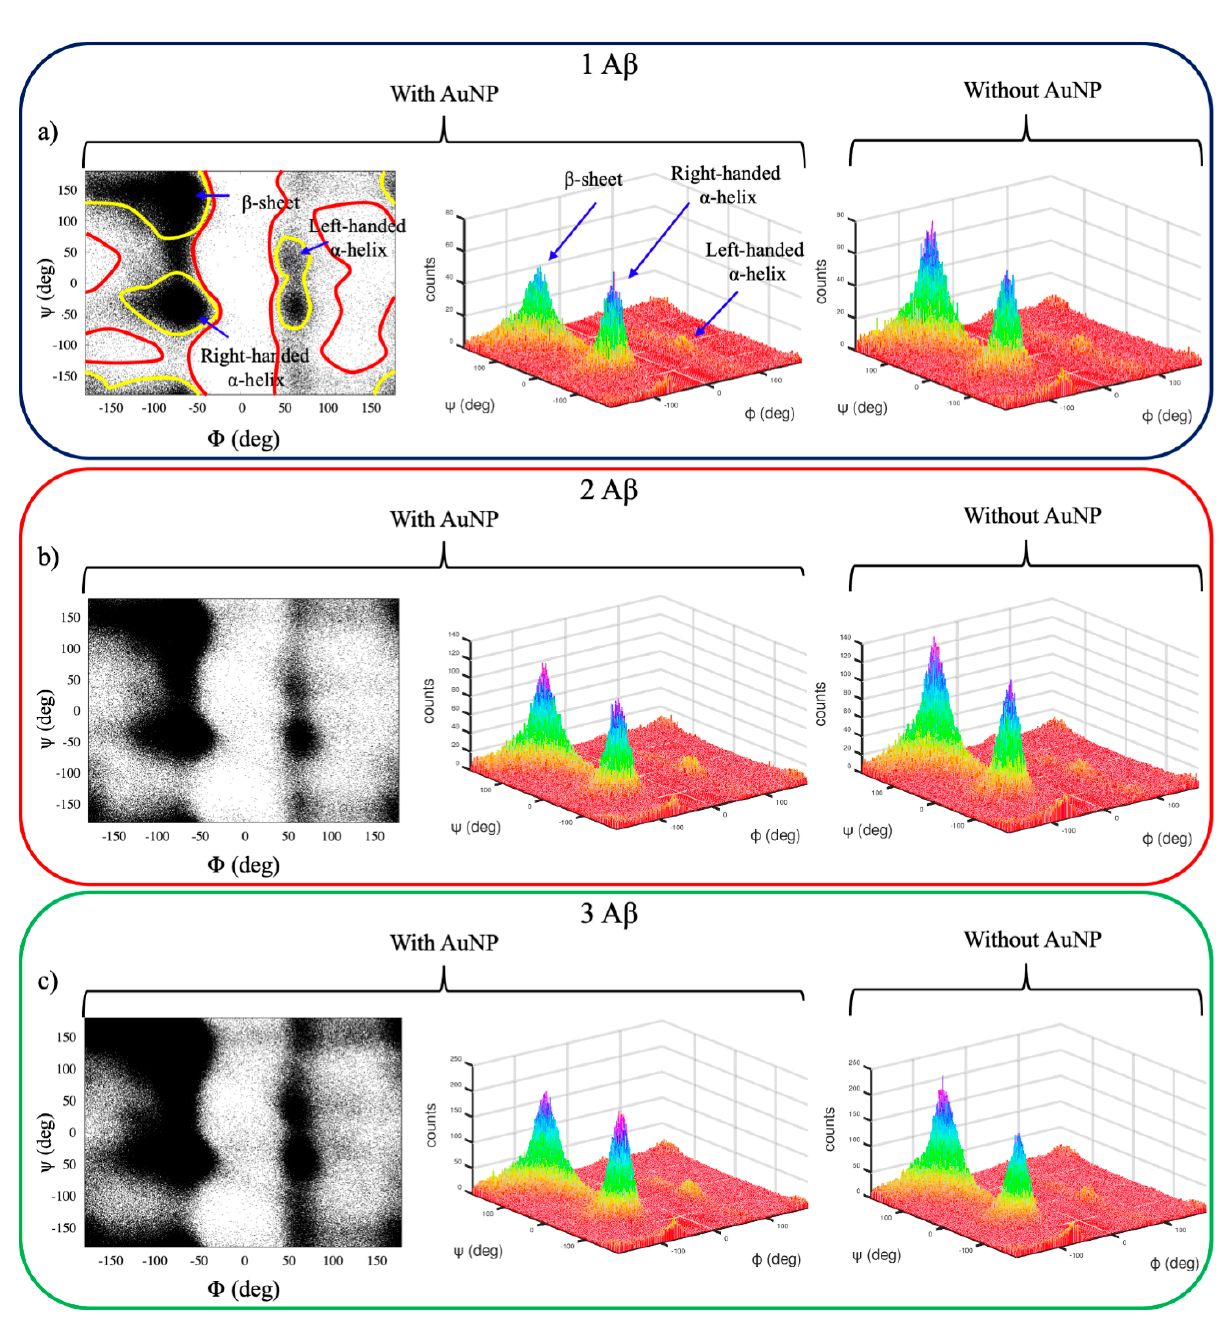
Figure 3. 2D and 3D Ramachandran plots obtained by sampling the dihedrals of the eight replicas of each A β (1–40) peptide during the 100-ns replica exchange solute tempering (REST) simulations with and without the presence of AuNP. The results for A β in the 1:1, 2:1, and 3:1 A β (1–40)/AuNP concentration ratios are reported in panels ( a – c ), respectively. In the 2D plots, the regions delimited by yellow lines are the most populated and are associated with a well-defined secondary structure, while the regions delimited by red lines are poorly sampled. In the 3D plots, the most probable structures are colored in purple, while the least probable structures are colored in red. Φ and Ψ are defined as the N i − 1 , C i , C α i , and N i and the C i , C α i , N i , and C i+1 torsion angles, respectively.